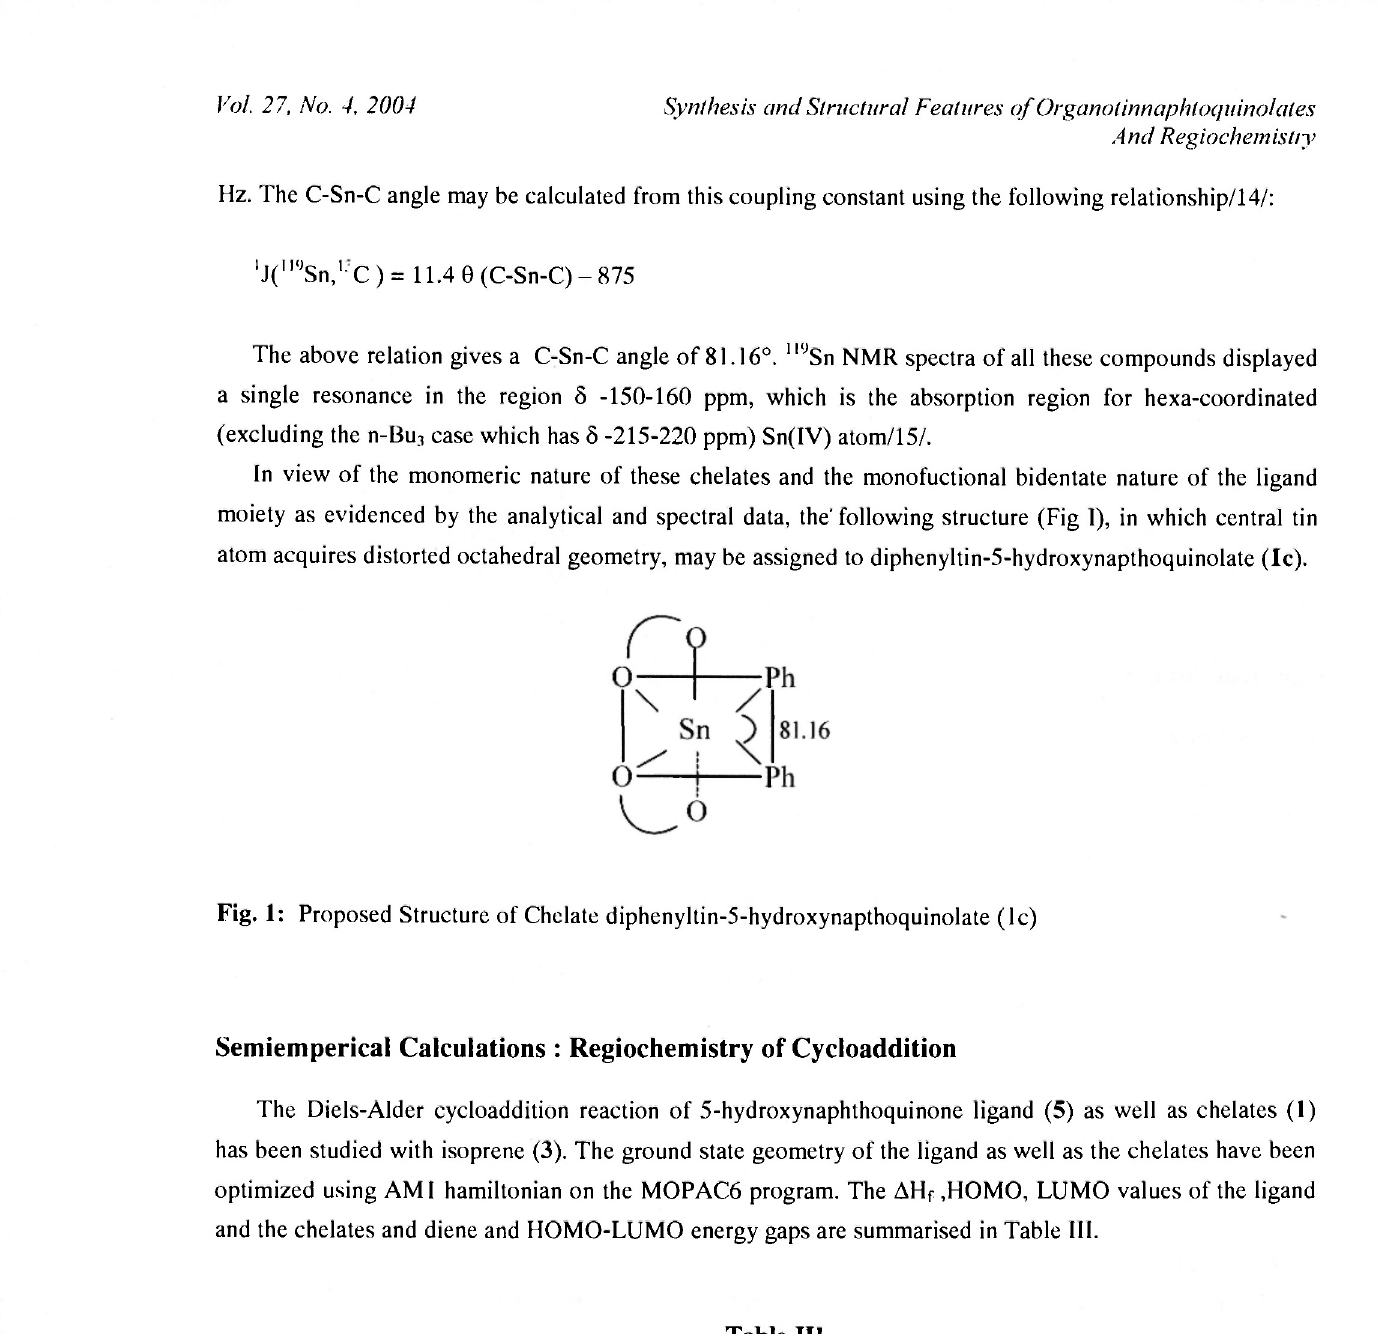
Semiemperical Calculations : Regiochemistry of